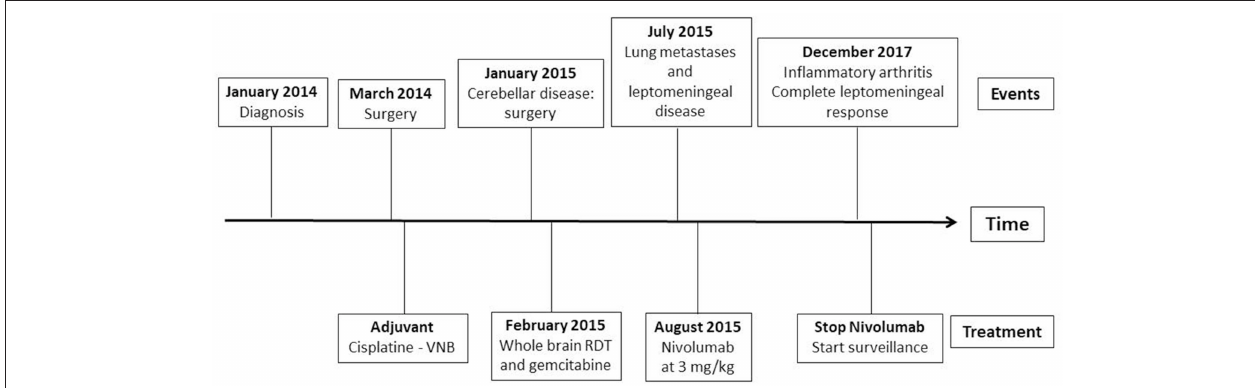
FIGURE 4 | Timeline of events since the diagnosis and summary of administered treatments.